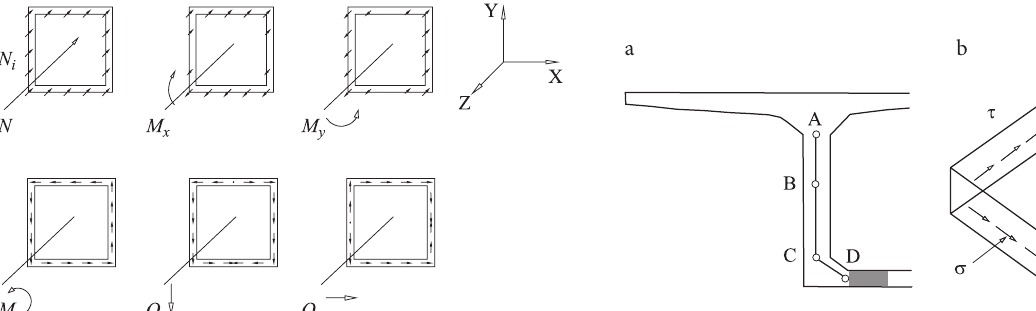
Fig. 2. Stress position of box girder: a – stress position; b – 2D stress in plane at D ( τ – shear stress, σ – normal stress)